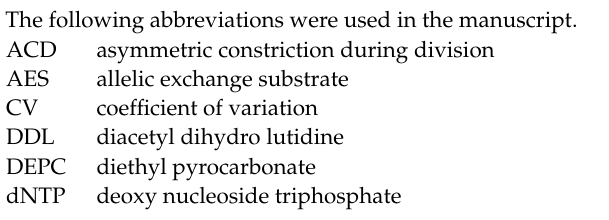
tions. Figure S2: Percentage error in the measurement of three different Msm cells. Figure S3: Proportion of the cells undergoing ACD/SCD after addition of 1X Middlebrook 7H9 and 10X Middlebrook 7H9 every 3 h from 0.1% glycerol concentration. Figure S4: Growth profiles of MSMEG_2932 _KO_pMV306-VC and MSMEG_2932 _KO_pMV306-MSMEG_2932, with respect to glycerol levels in the medium, and the proportion of the cells undergoing ACD/SCD. Figure S5: Growth profiles of MSMEG_2933_ KO_pMV306-VC and MSMEG_2933 _KO_pMV306-MSMEG_2933, with respect to the glycerol levels in the medium, and the proportion of the cells undergoing ACD/SCD. Figure S6: Growth profiles of MSMEG_2936_ KO_pMV306-VC and MSMEG_2936 _KO_p- MV306-MSMEG_2936, with respect to glycerol levels in the medium, and the proportion of the cells undergoing ACD/SCD. Table S1: Bacterial strains and plasmids with Supplementary references. Table S2: Oligonucleotide primers used for cDNA synthesis and real time PCR. Table S3: Oligonu- cleotide primers used for the gene replacement of MSMEG_2932, MSMEG_2933 , and MSMEG_2936 with res- hyg R -res and confirmation. Table S4: Coefficient of variation (CV), a measure of the disper- sion in the location of the site of constriction from the mid-cell site. Table S5: Oligonucleotide primers used for the genome integrant complement generation of knockout strains of MSMEG_2932 KO, MSMEG_2933 KO, and MSMEG_2936 KO. Scheme S1: Msm cell harvesting, fixation, DIC imaging, and data acquisition for measuring proportion of ACD and SCD. Scheme S2: MSMEG_2932 gene knockout strategy. Scheme S3: Msm MSMEG_2932 -KO clone confirmation using PCR and genomic DNA. Scheme S4: MSMEG_2933 gene knockout strategy. Scheme S5: Msm MSMEG_2933 -KO clone confirmation using PCR and genomic DNA. Scheme S6: MSMEG_2936 gene knockout strategy. Scheme S7: Msm MSMEG_2936-KO clone confirmation using PCR and genomic